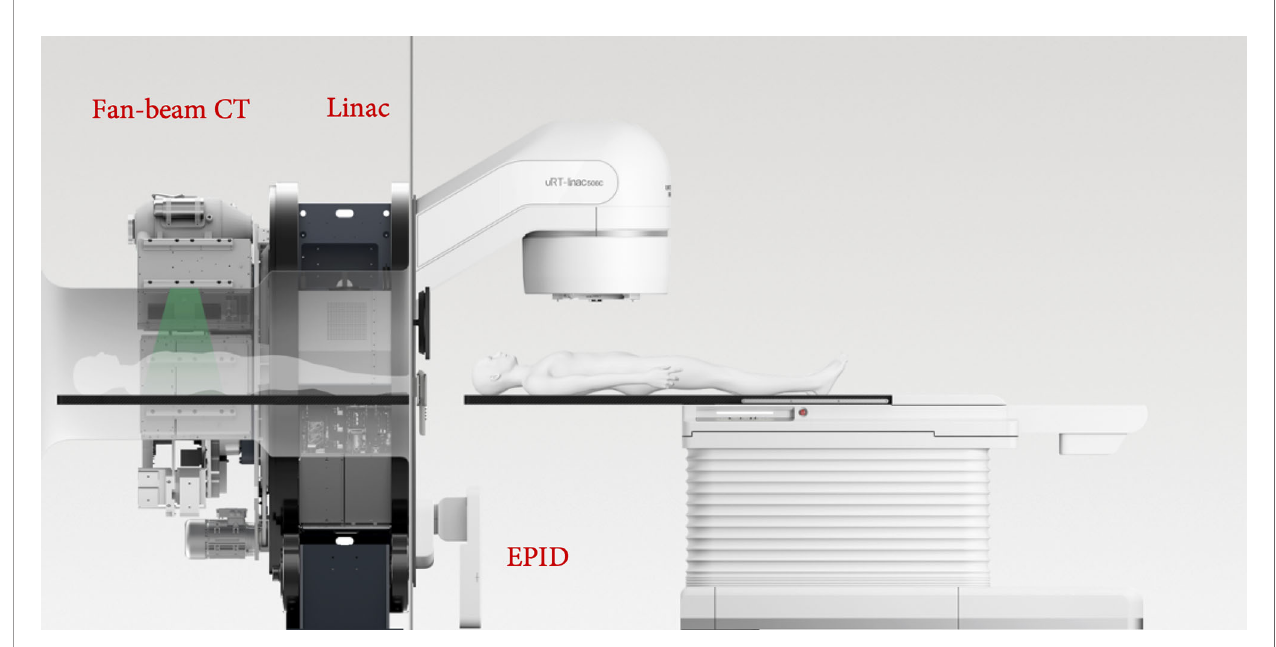
FIGURE 3 | The CT-Linac